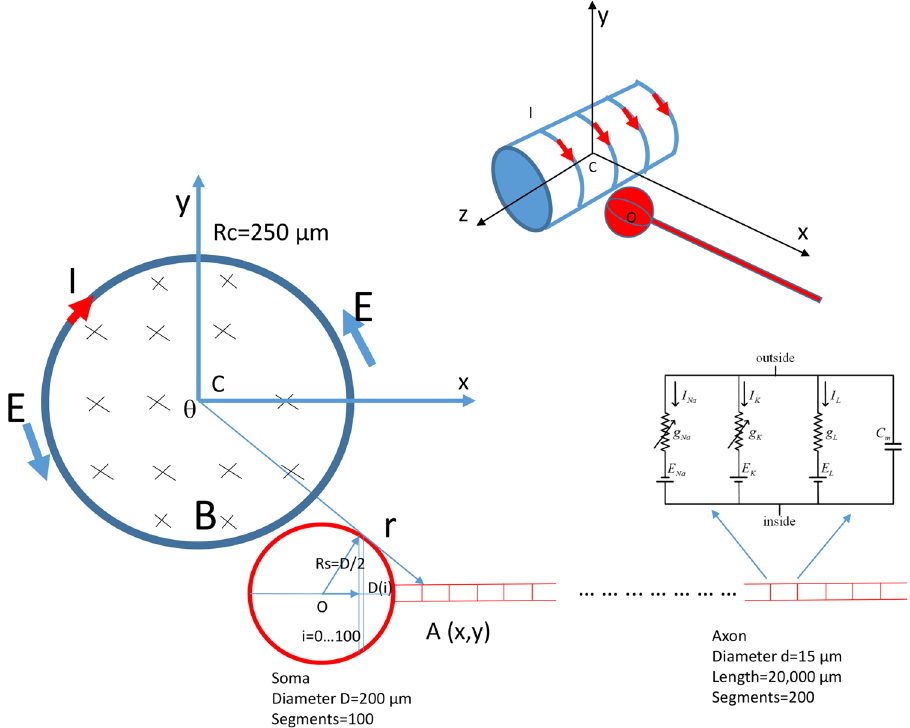
Figure 8. Multi-compartment neuron model under magnetic stimulation. The neuron was stimulated by a cylindrical coil (radius 250 μm), whose axis overlapped with the z-axis. High frequency square pulses were delivered to the coil to induce the electric field (E: electric field, I: coil current, and B: inward magnetic field generated by the electric current). The modeled neuron included a spherical soma (200 μm in diameter, 100 segments) and a cylindrical axon (15 μm in diameter, 20,000 μm in length, 200 segments). Each neural compartment was inserted with Hodgkin-Huxley type ion channels. The center of the soma (O) is located close to the center of the coil (C), and the axon was in the x direction. Point A (x, 0) was a point on the neuron, whose distance to the center of the coil is